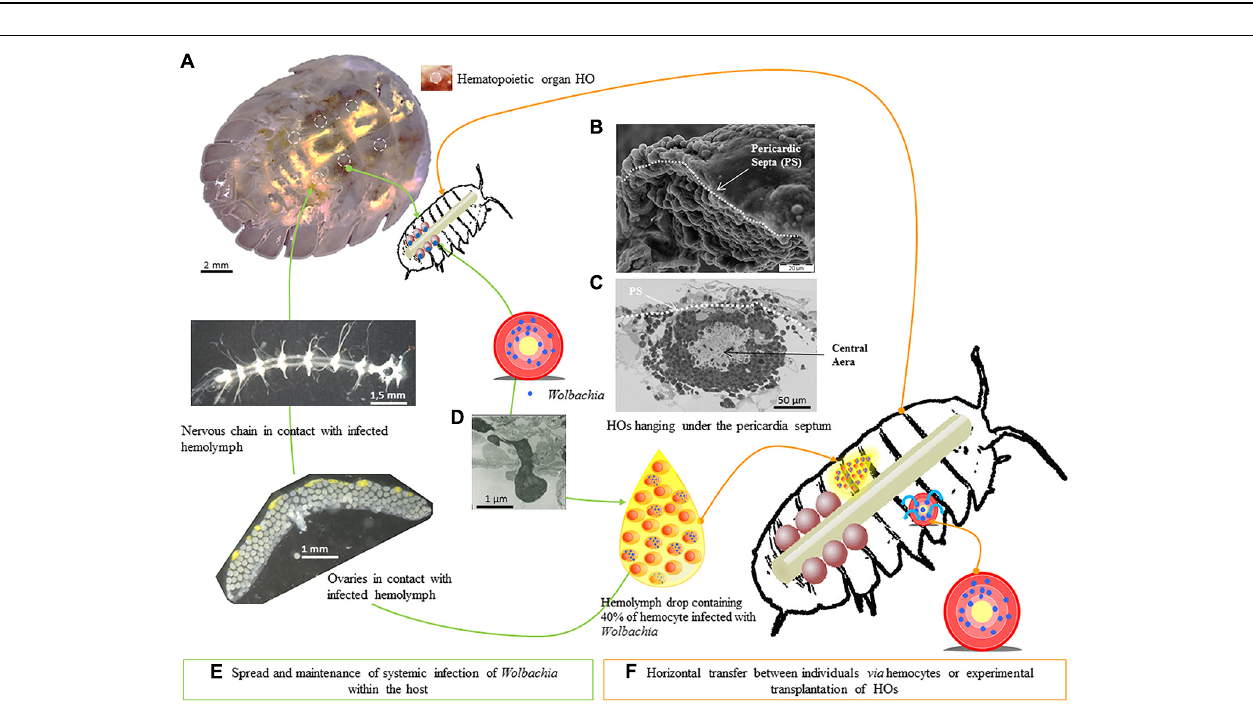
FIGURE 6 | Hematopoietic organs as cornerstone for Wolbachia propagation. The six hematopoietic organs are localized between the sixth and seventh pereion segments and the first telson segment (A) , along the dorsal vessel and hanging under the pericardia septum (B,C) . The six HOs were 150 μ m long, 150 μ m large and 50–60 μ m thick (C) . Each HO contained only hemocytes presenting different maturation stages, the least mature being in the central area (C) . The HOs discharge hemocytes in the hemolymph probably by diapedesis (D) . In terrestrial isopod, hemolymph is a vital biological fluid notably implied in the transportation of oxygen and the circulation of immune cells in the general cavity (E) . Transmission of Wolbachia can also happen when a hemolymph contact occurs between two wounded animals (F) .